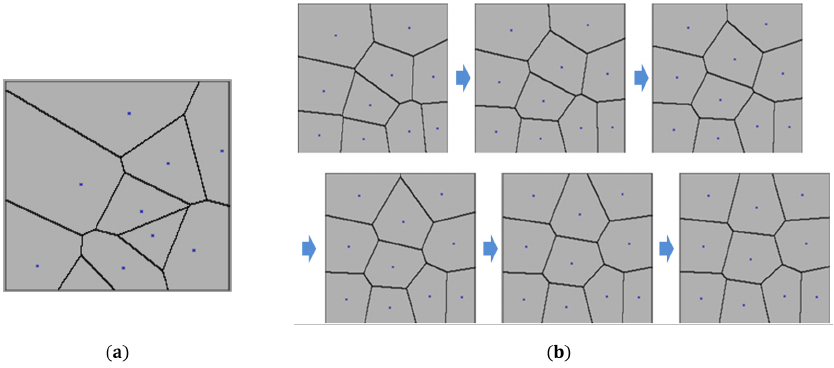
Figure 3. Modeling of indoor spaces: ( a ) Voronoi diagram; ( b ) Process of Lloyd’s